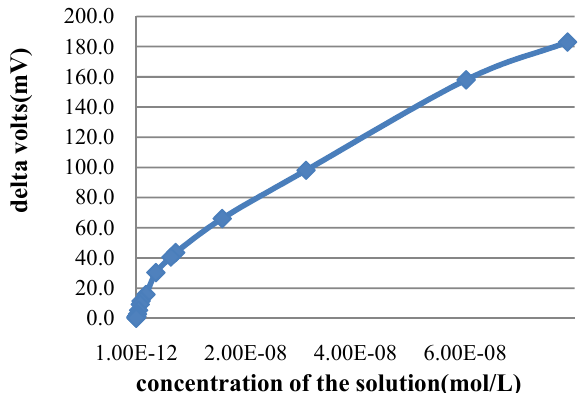
Figure 5. The relationship of the concentrations of the fluorescein solution samples range from 10 × 10 − 8 to 10 × 10 − 12 scale and the voltage differences.